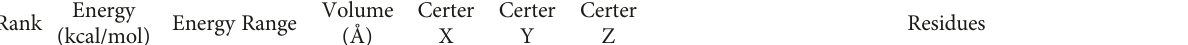
Table 8: Top 10 binding pockets with binding residues, energy, and volume of OROV